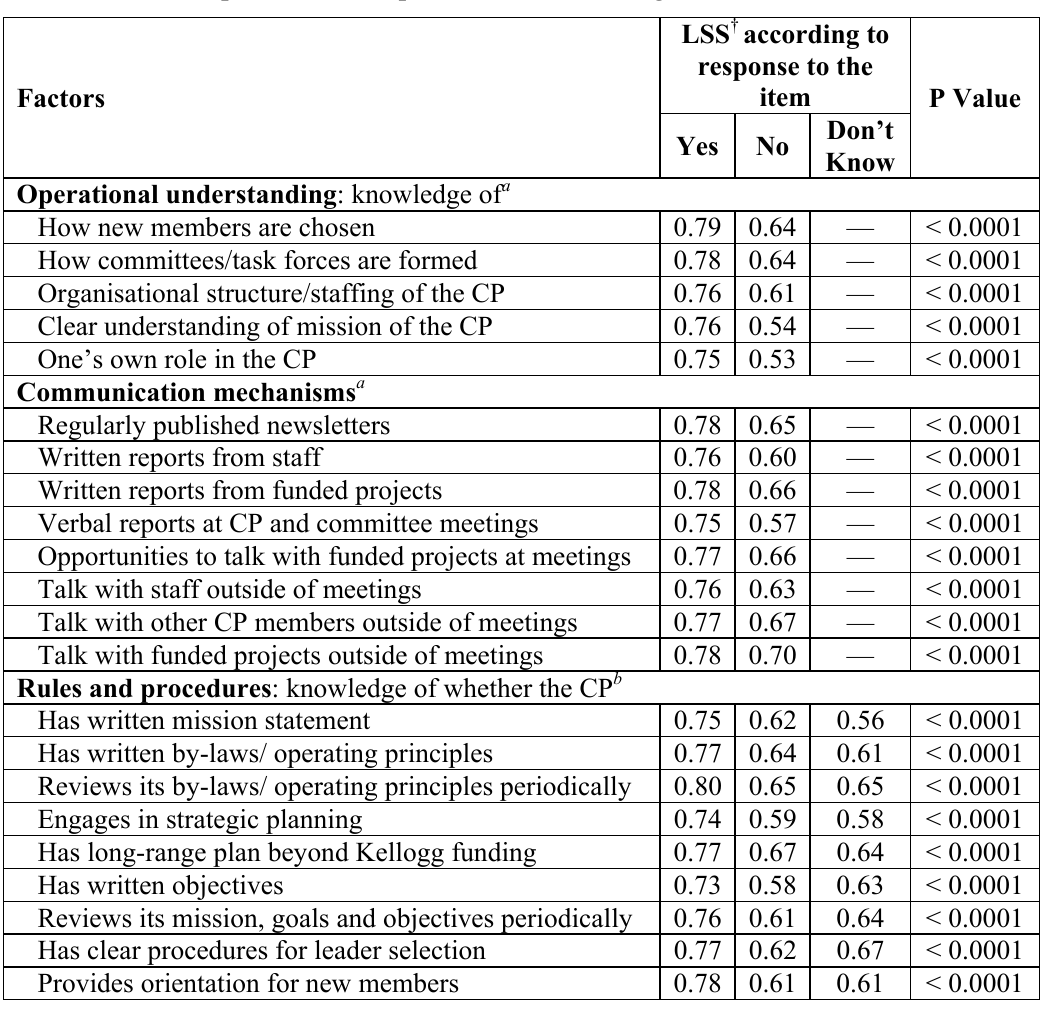
Table 5. Participant Leadership Skill Score for categories of selected CP Factors.